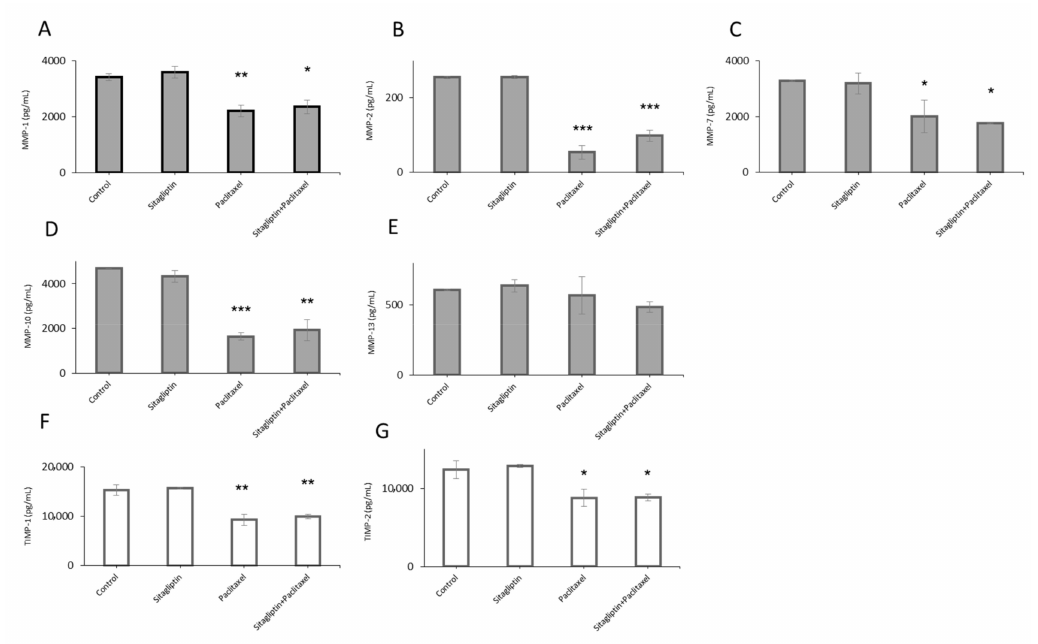
Figure 1. Metalloproteinase (MMP) and metalloproteinase inhibitors’ (TIMP) profiles in SKOV-3